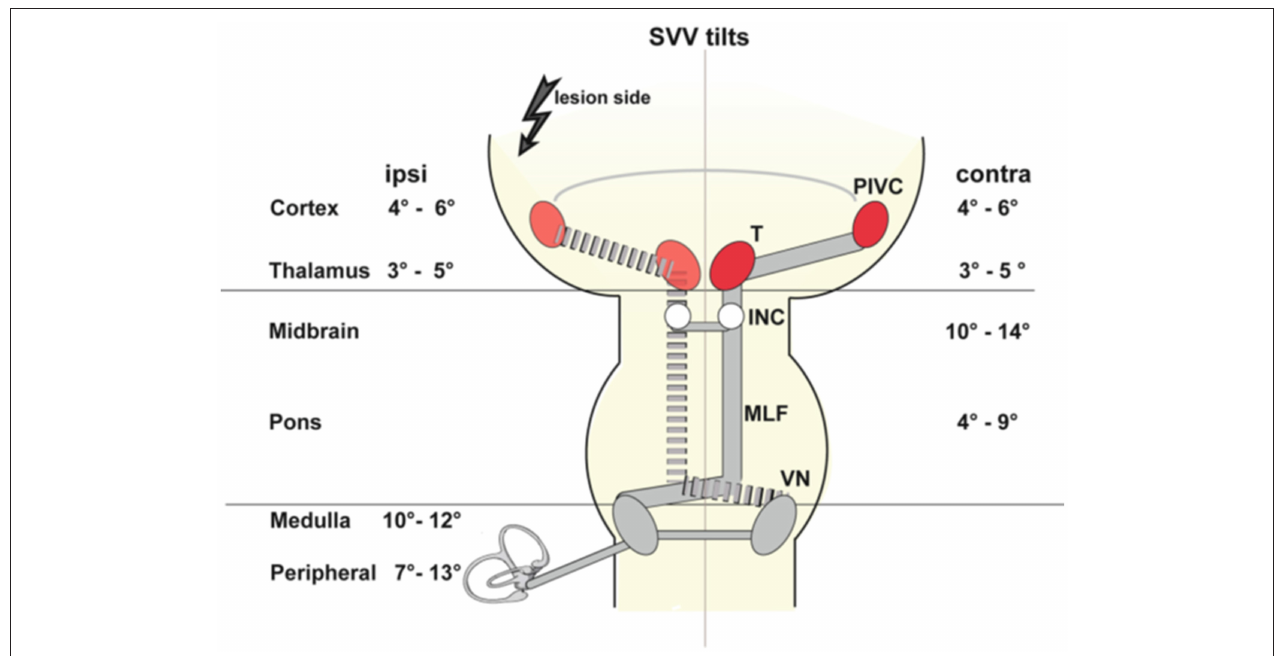
FIGURE 1 | Schematic graviceptive pathways together with the amount of SVV tilt (in deg) for ipsilateral (ipsi) and contralateral (contra) lesions depending on the level of acute unilateral vestibular damage. The range of the mean values was calculated from a total of 15 published studies (see Table 1 for reference numbers). The four major messages are as follows: (i) In peripheral and pontomedullary brainstem lesions SVV tilts are ipsilateral. (ii) In pontomesencephalic vestibular pathway lesions up to the INC, SVV tilts are contralateral. (iii) In vestibular thalamic and cortical lesions, SVV tilts may be either ipsilateral or contralateral with an intraindividual consistency and an equal distribution interindividually. (iv) The amount of SVV tilt is maximal in complete peripheral lesions (mean up to 13 deg) and in brainstem lesions (mean up to 12–14 deg), and less in lesions of the vestibular thalamus and cortex (mean up to 5–6 deg). INC, interstitial nucleus of Cajal; MLF, medial longitudinal fascicle; VN, vestibuar nucleus [From Glasauer et al.